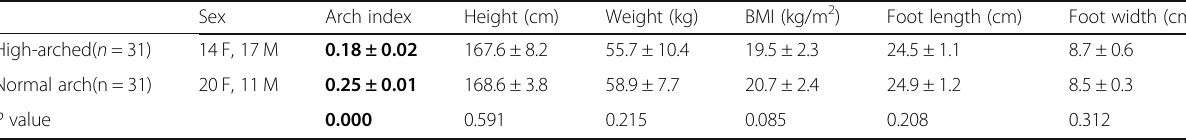
Table 1 Statistics of subjects